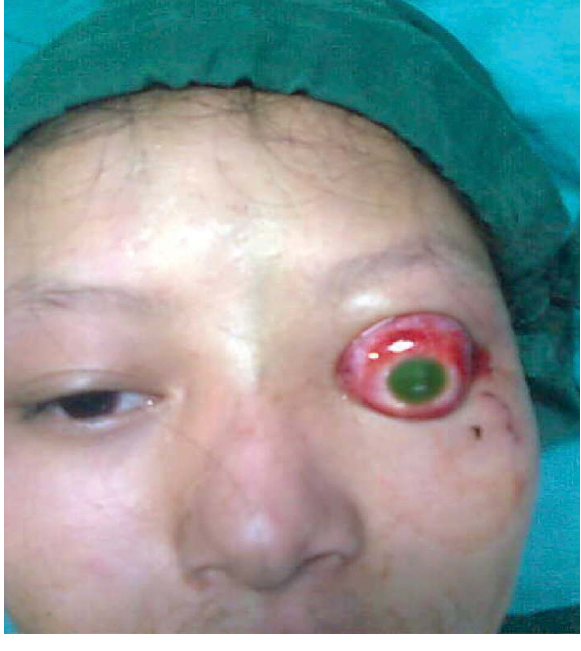
Figure 1. Pre-operative photograph with globe luxation There was a large corneal abrasion measuring 7.5 mm and 10 mm. The anterior chamber depth was normal and quiet. The pupil was 3 mm, round, regular and reacting to light with the absence of any relative afferent papillary defect. The optic disc, macula and retinal periphery were grossly normal. The lids, adnexae and anterior and posterior segment (cid:2) ndings on RE were unremarkable.